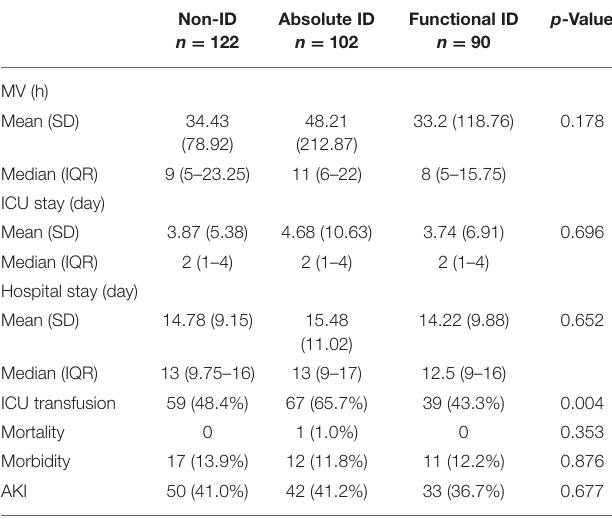
TABLE 5 | Clinical outcomes of the patient population.